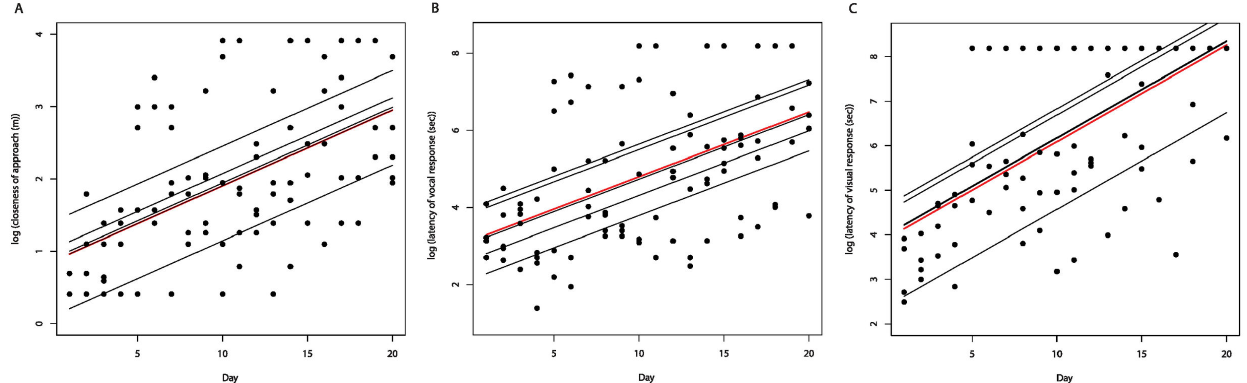
Figures 3. In repeated playback experiments, Plain-tailed Wren Thryothorus euophrys groups showed weaker responses over time measured by (a) closeness of approach to the speaker, (b) latency of vocal response, and (c) latency of visual response. In each figure the red line shows the population trend line (all wren groups combined) and the other lines show fitted trend lines for each group from Gaussian mixed-effect models with random intercepts. Data points with maximum values on the y- axis indicate no response (i.e. latency of response of 3,600 seconds or closeness of approach of 50 m). doi: